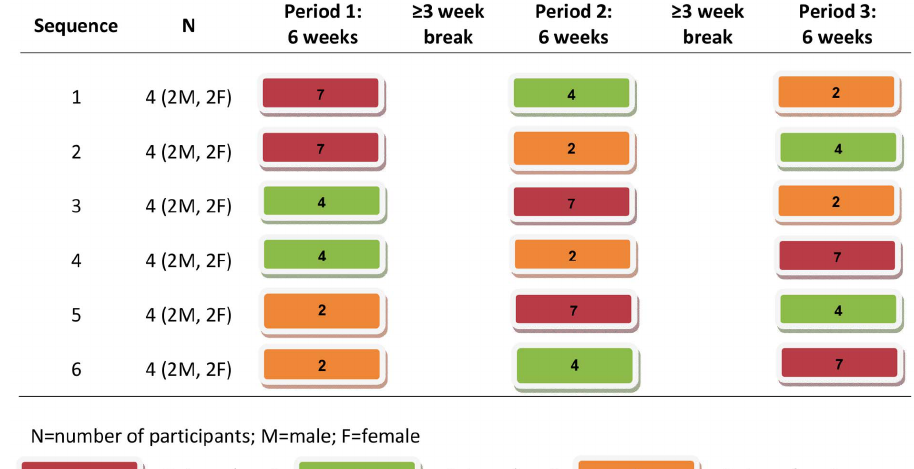
Figure 2. Dosing scheme for the STRAND Study.